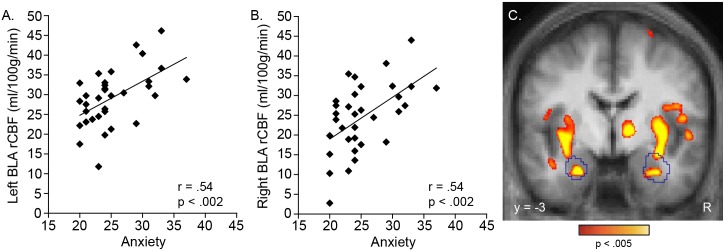
Perfusion of the basolateral nucleus of the amygdala (BLA) is correlated with anxiety levels.Significant correlations were found between anxiety levels and perfusion of the left (A) and right (B) basolateral amygdala (BLA), as defined using anatomical regions-of-interest. These findings were then confirmed in a voxel-wise, whole brain regression analysis (C). In C, the BLA regions-of-interest are outlined in blue; the voxel-level display threshold is p<.005 (showing only clusters surviving whole-brain correction, see Methods). Clusters that showed cluster-wise significance (p<.05, whole brain corrected) are reported in the text and in Table 2. R, right.